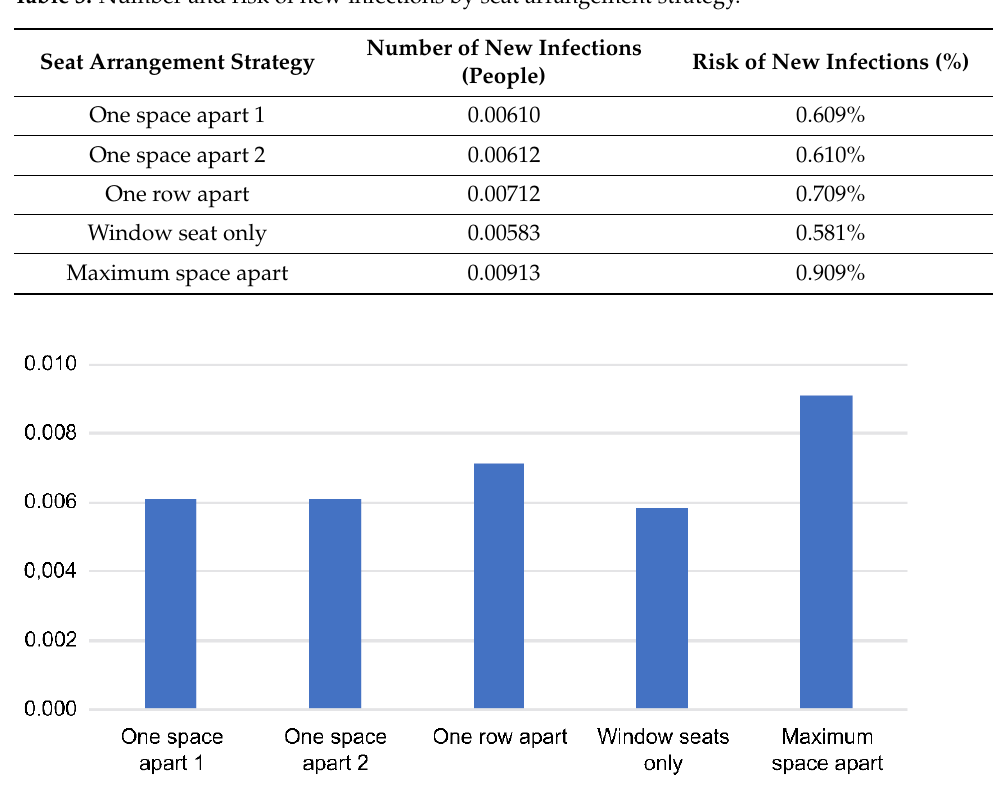
Figure 8. Seating arrangement strategies.